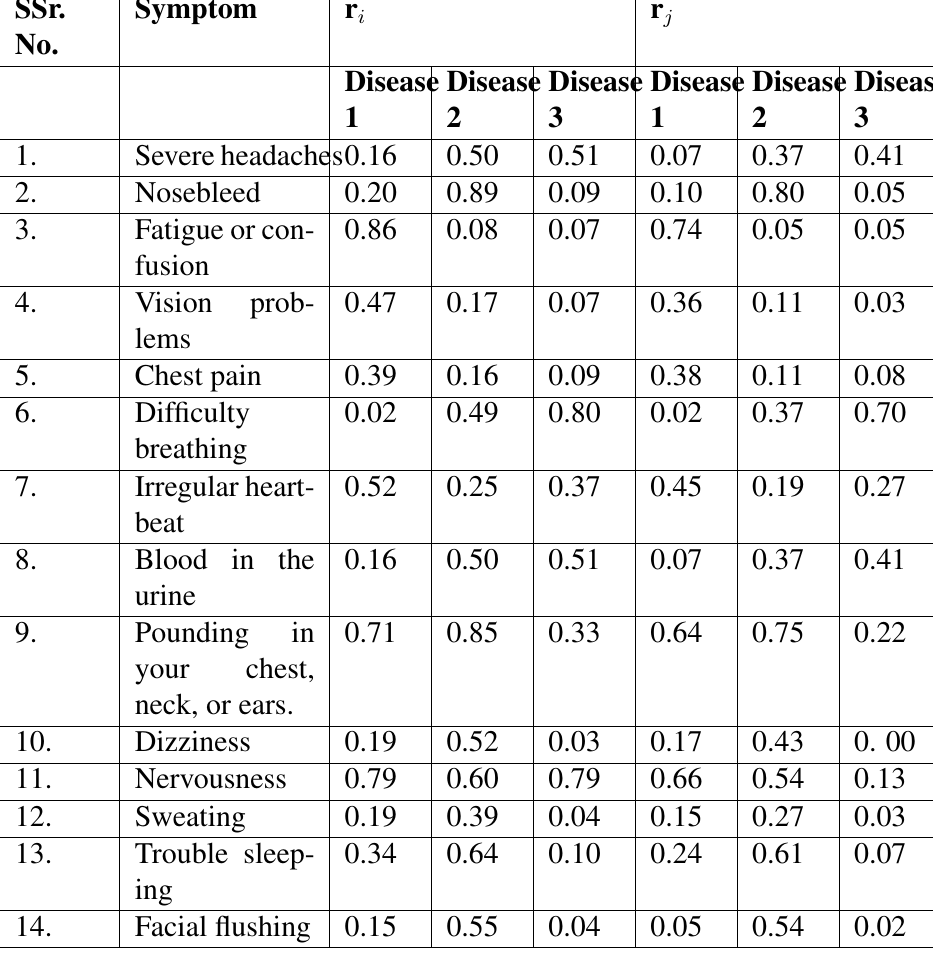
Table 4: The existence of illness is confirmed by the symptoms ‘d’